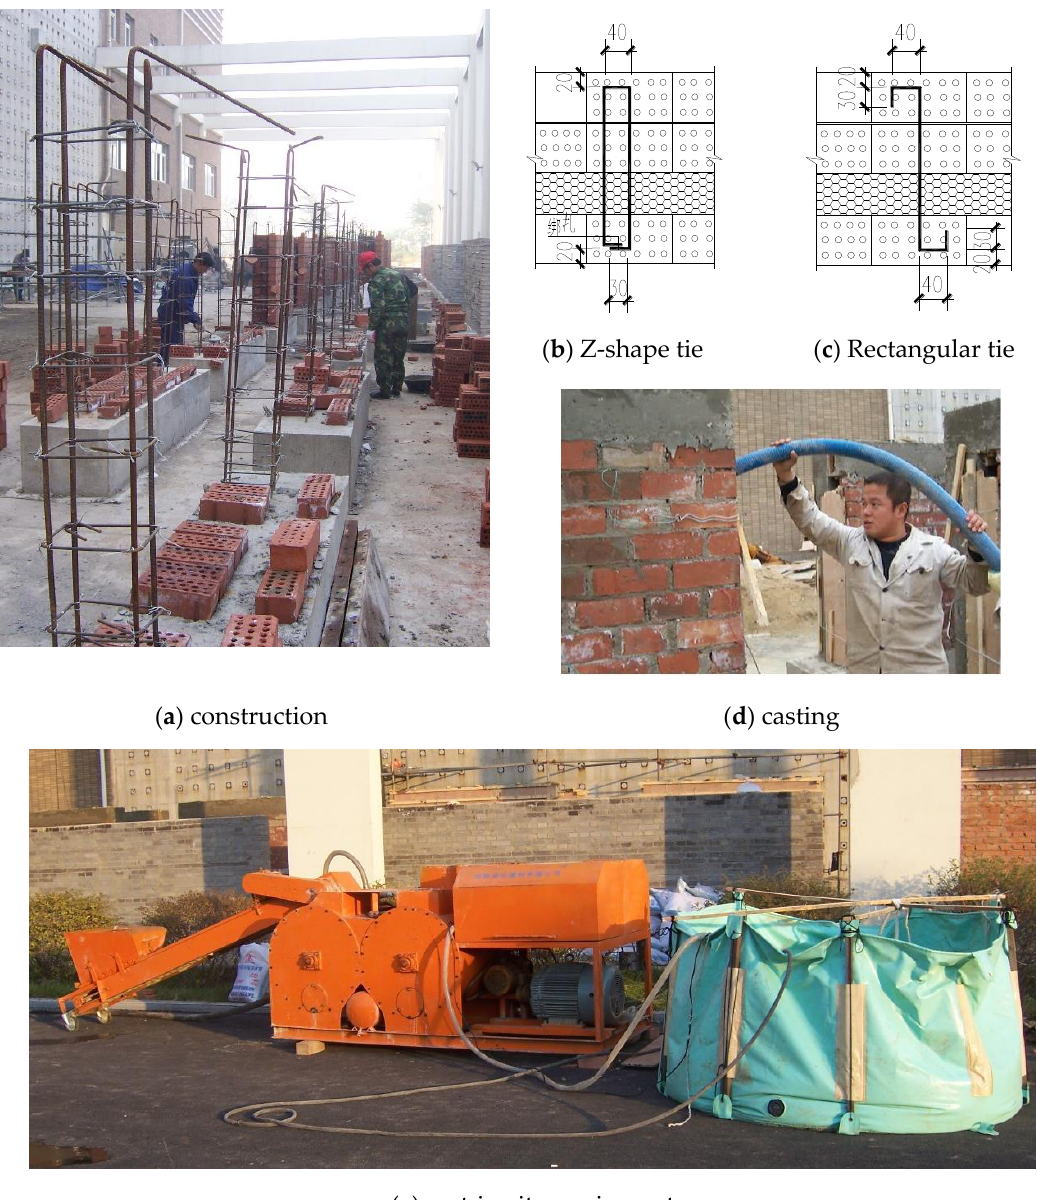
Table 1. The specimens are denoted WDS h(or z) S v - T - P , where D indicates the tie shape, H and Z stand for rectangular and Z-shaped ties, respectively [15]; S h is the horizontal spacing of ties which was 600 or 800 mm; S v is the vertical spacing of ties which was 300 or 400 mm; T is the thickness of insulating layer; and P is the applied axial stress. Four levels of axial compression, expressed as σ 0 were used, as shown in Figure 2. All walls were 1400 mm high and 1740 mm wide, corresponding to a height to length ratio of 0.8. The thickness of the inner leaf was 240 mm, whereas the thickness of the outer leaf was 120 mm. The thickness of the insulating layer was varied from 80 to 120 mm with 20 mm intervals. The solid wall was 370 mm thick, having the same dimension as the cast-in-situ masonry cavity walls, but without a cavity.